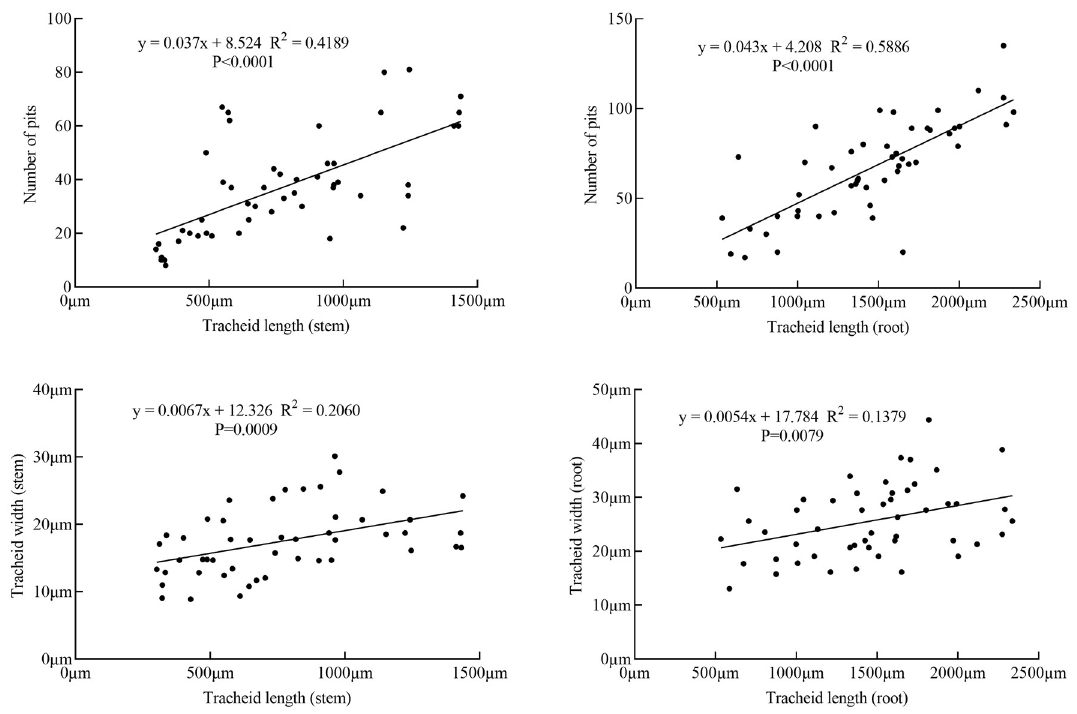
Fig 10. Scatter plot of tracheid length, tracheid width and number of